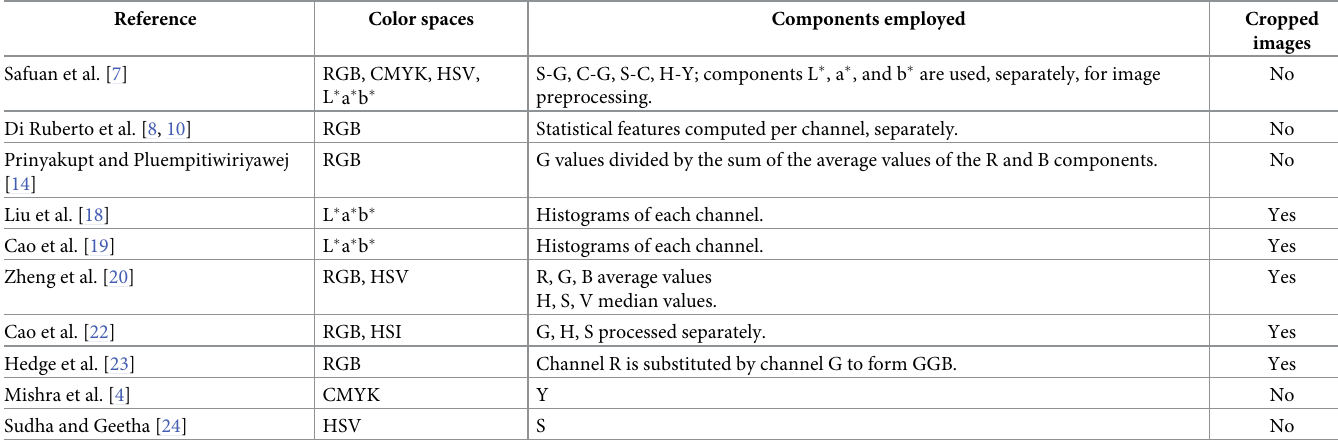
Table 7. Color spaces and color components employed in related